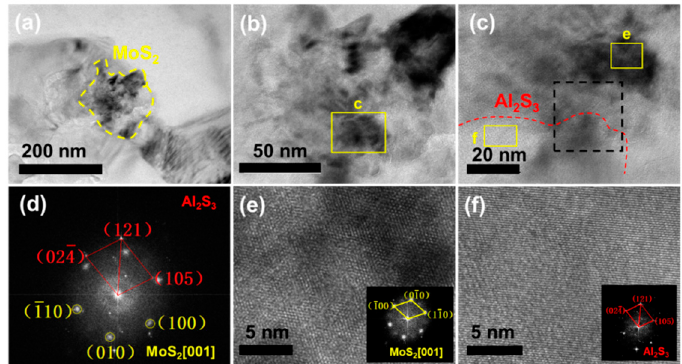
Figure 8. TEM microstructure of 1.5 wt.% FLM/Al composite sintered at 630 °C. ( a , b ) MoS 2 in Al matrix, ( c ) HRTEM of yellow box in ( b ), ( d ) FFT of black box in ( c ), ( e ) HRTEM of MoS 2 , ( f ) HRTEM of Al 2 S 3.